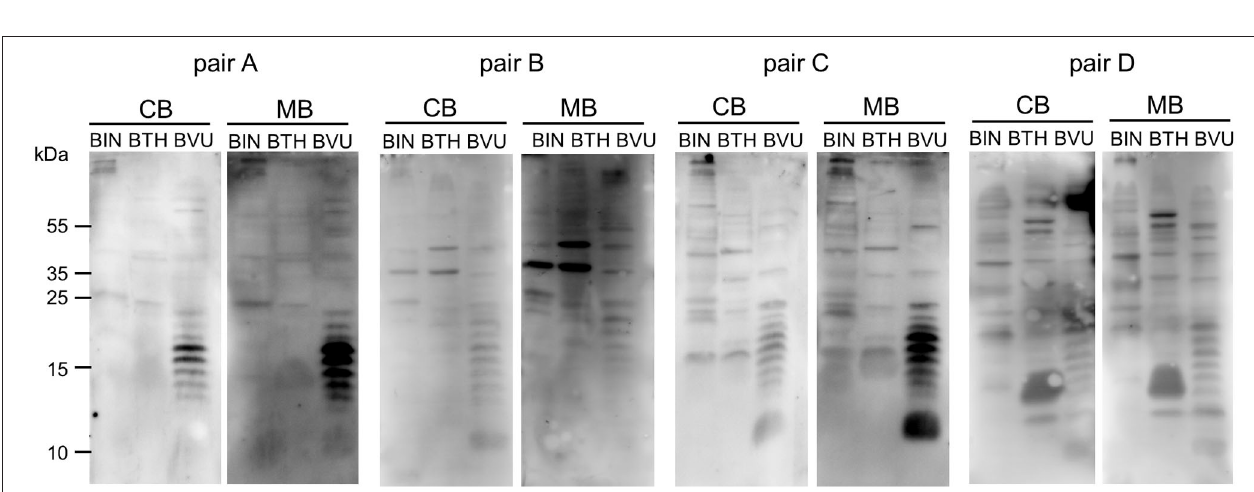
FIGURE 7 | IgG of cord blood and matched maternal blood target identical antigens on commensal bacteria. IgG binding to components of bacterial cell lysates of B. intestinalis (BIN), B. thetaiotaomicron (BTH), and B. vulgatus (BVU) for matched pairs of cord blood and maternal blood, using a serum dilution of